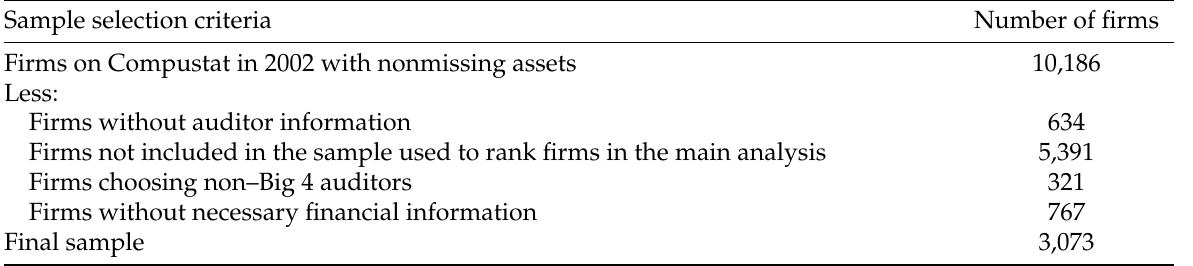
Table 4: Sample selection: Subsequent analysis Sample selection